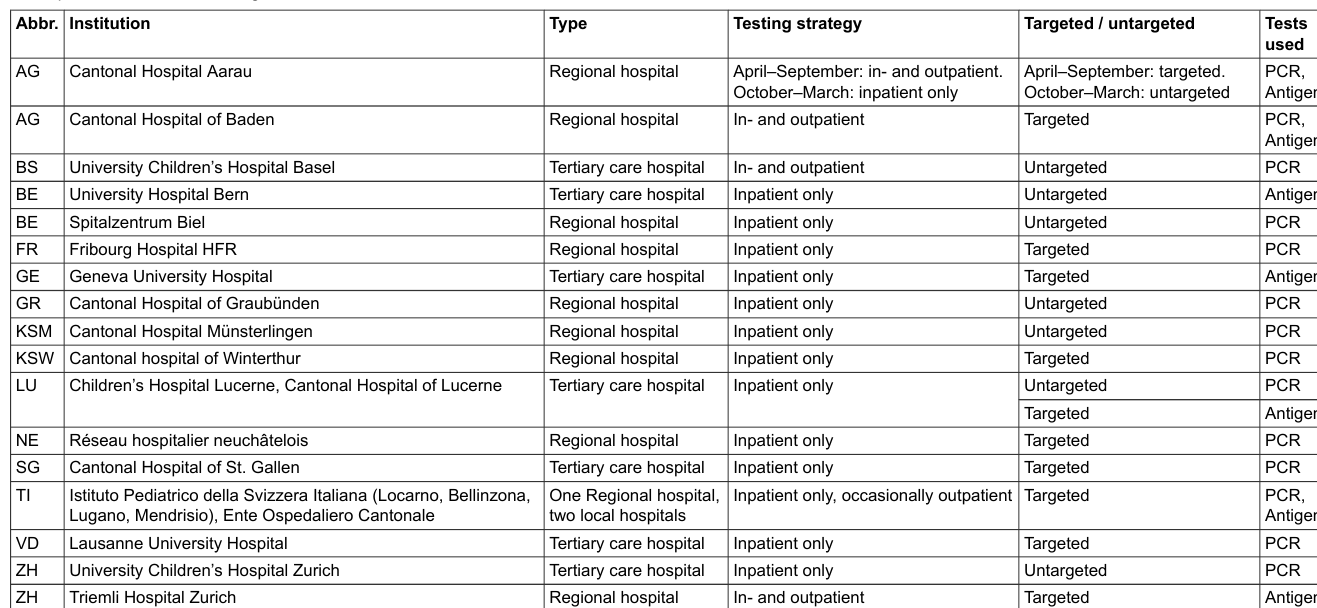
Table 1: Description of centres and testing